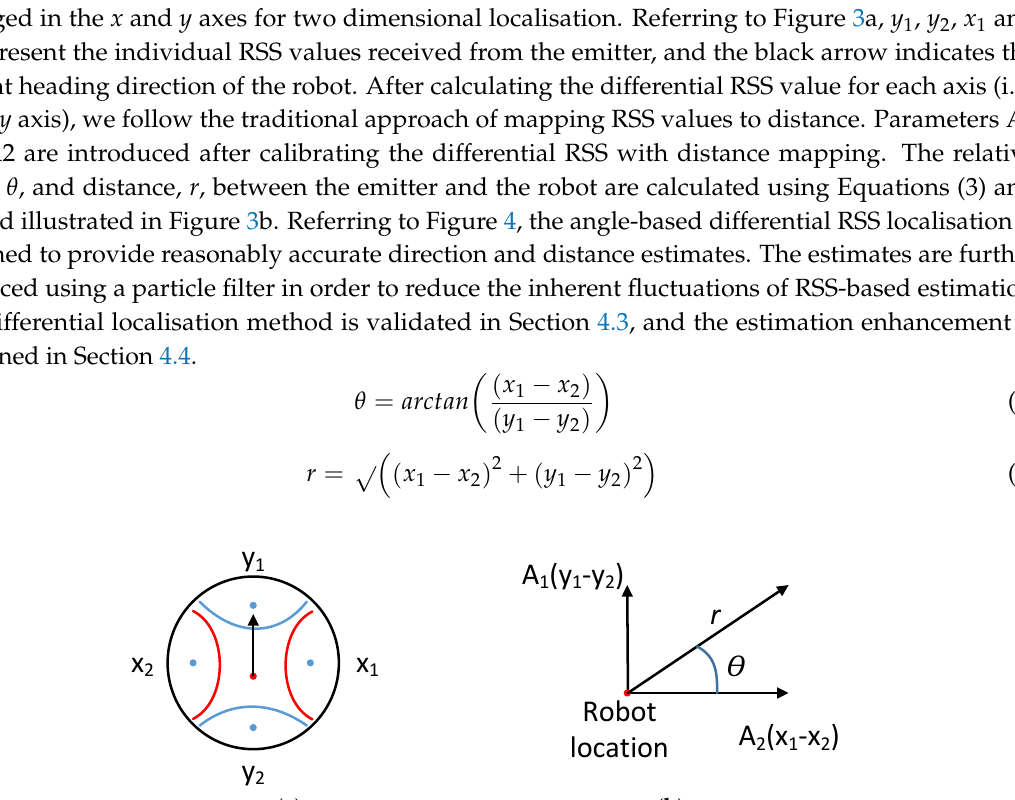
Figure 4. Angle-based differential RSS localisation algorithm.